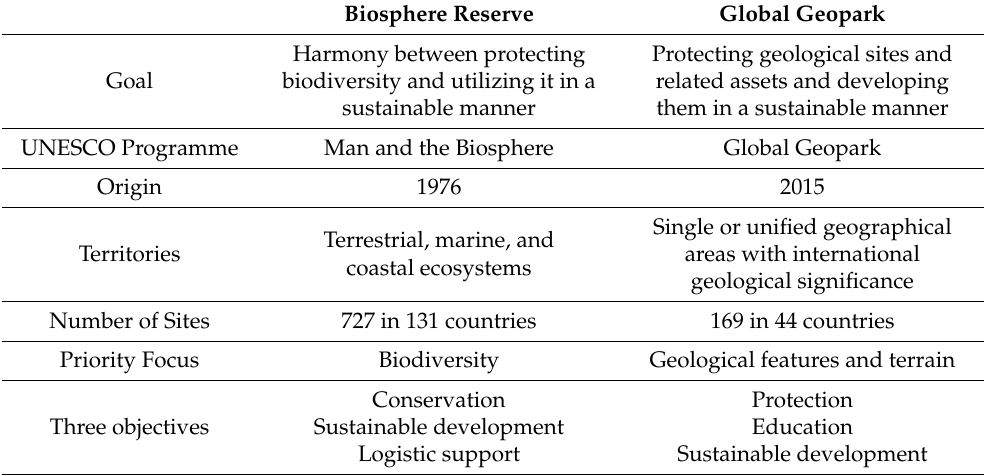
Table 1. Differences between UNESCO Designated Biosphere Reserve and UNESCO Global